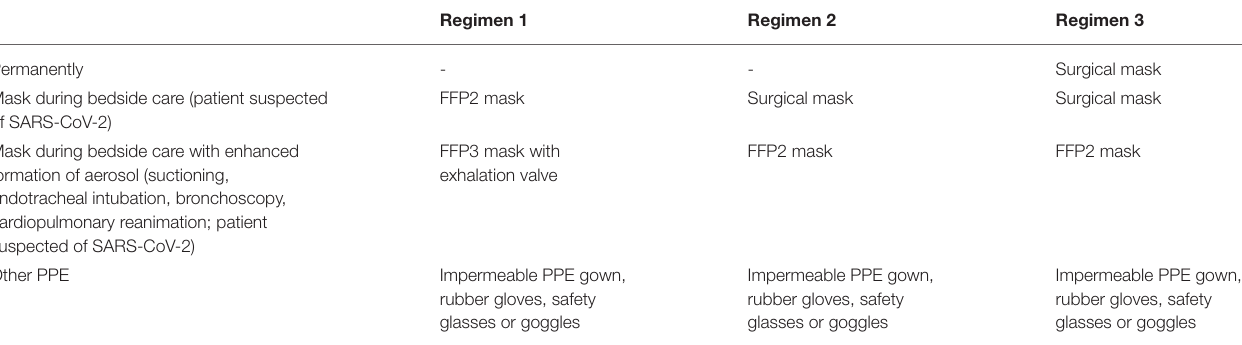
TABLE 1 | Regimens of personal protective equipment (PPE); see Supplementary Table 1 for chronology of employment of PPE regimens. Regimen 1